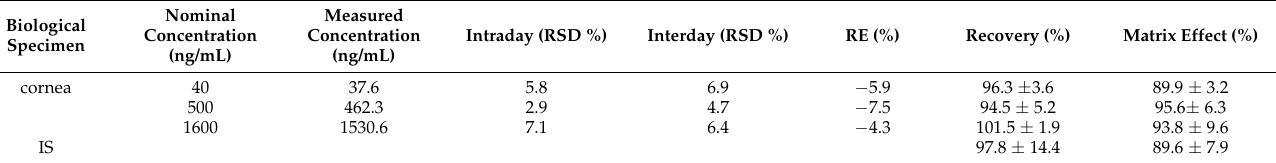
Table 2. Precision, accuracy, recovery, and matrix effect of gatifloxacin in the cornea ( n = 6).